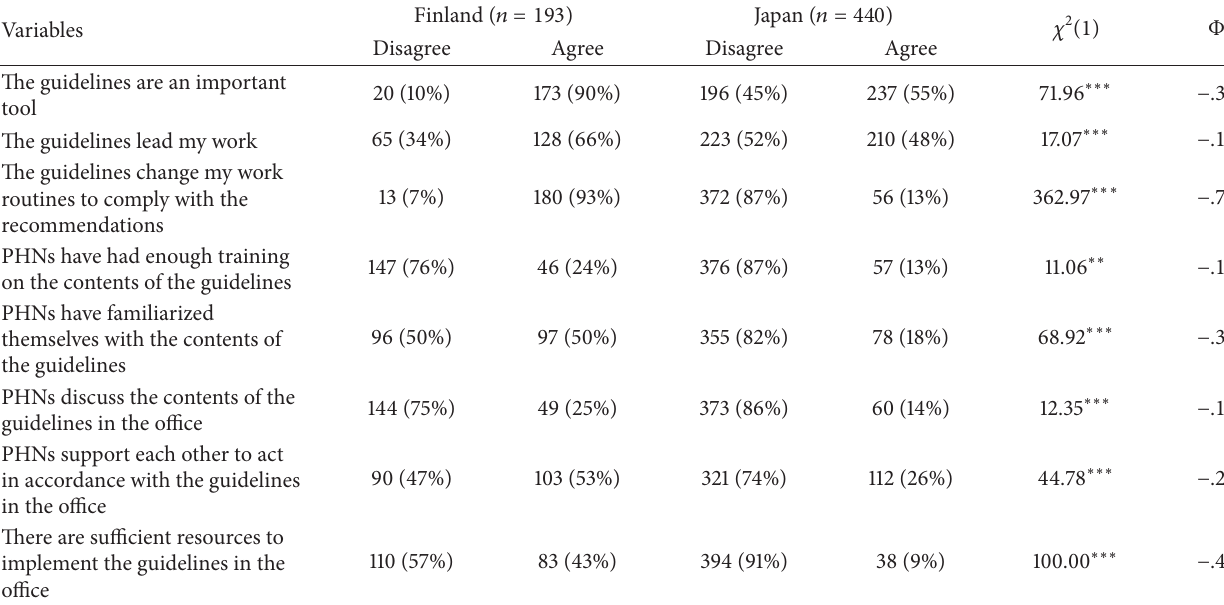
Table 6: Implementation of guidelines on child